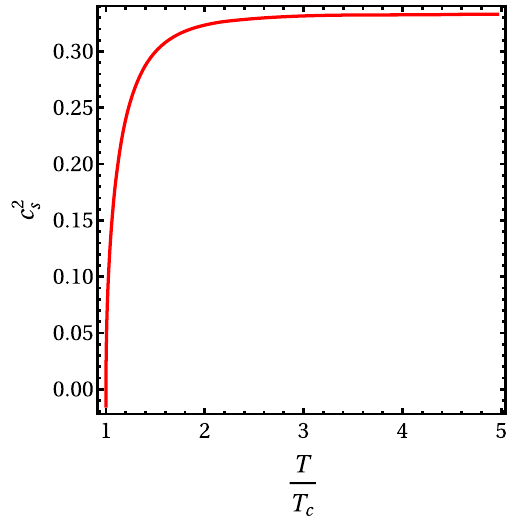
Fig. 3 The square of the sound velocity c 2 s as a function of scaled temperature T / T c with k = 0 . 43 GeV and G 5 / L 3 = 1 . 26